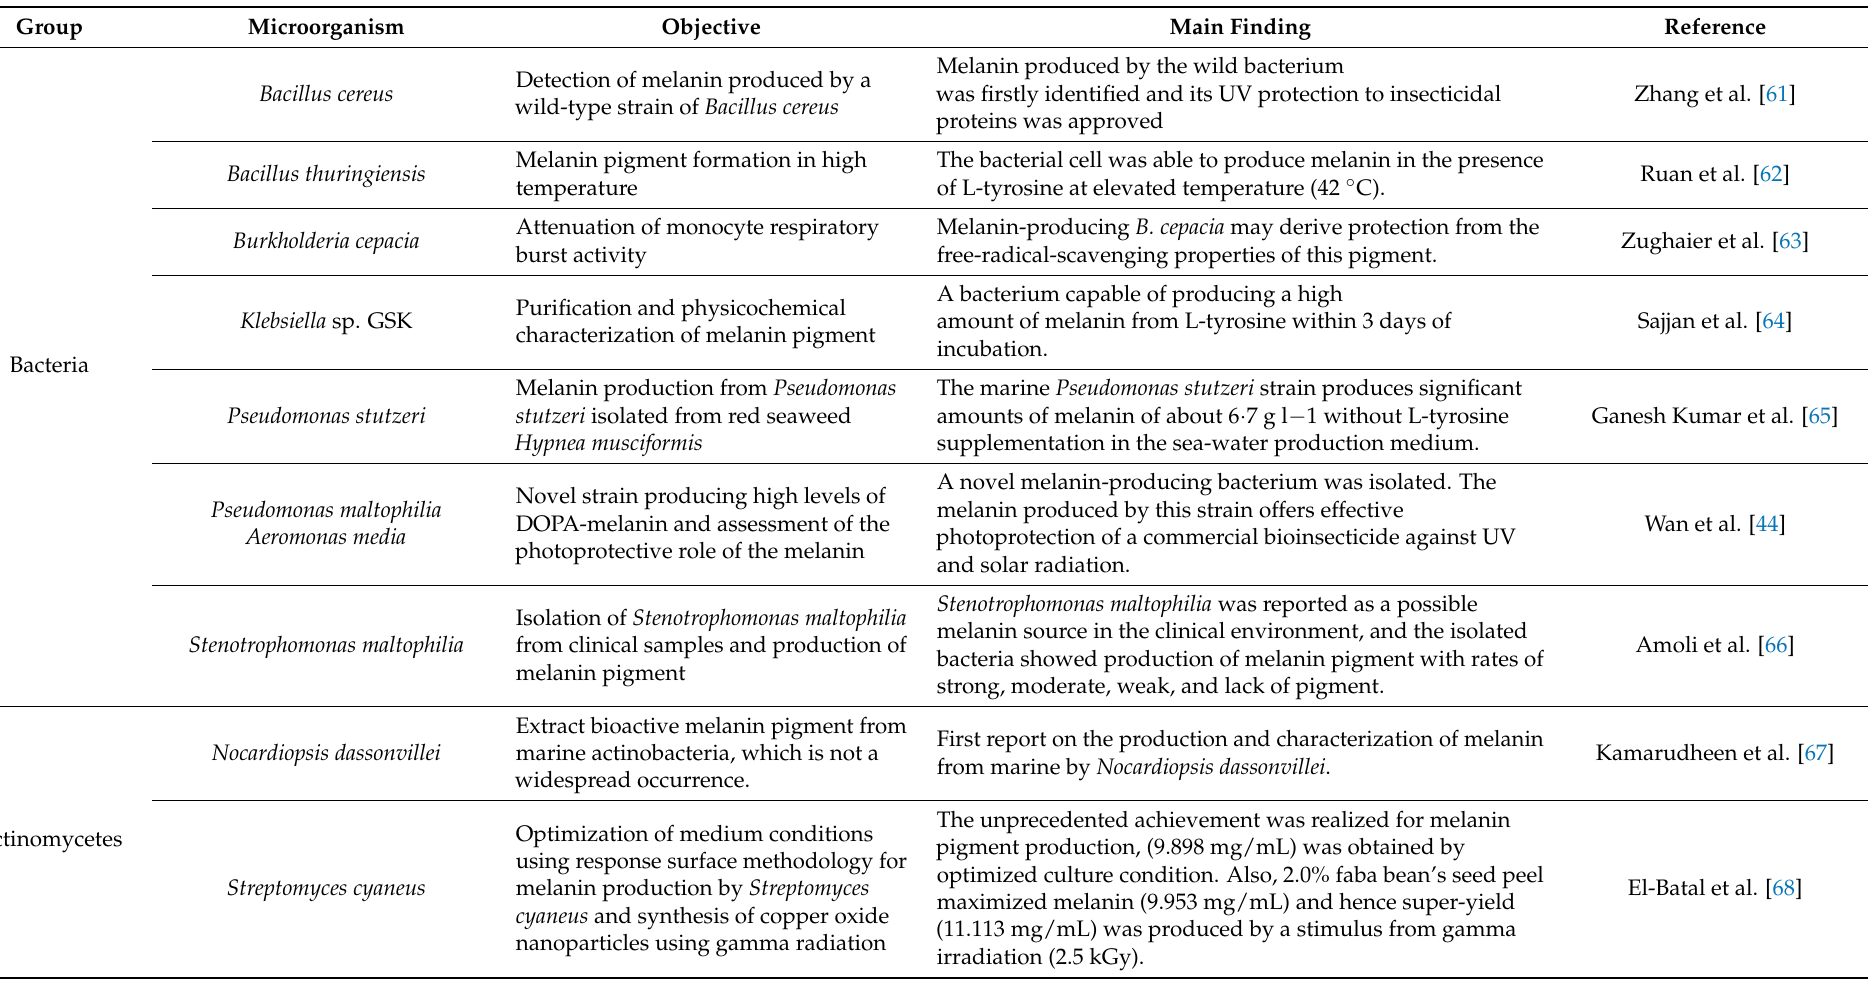
Table 1. List of some bacteria and fungi that produce microbial melanin